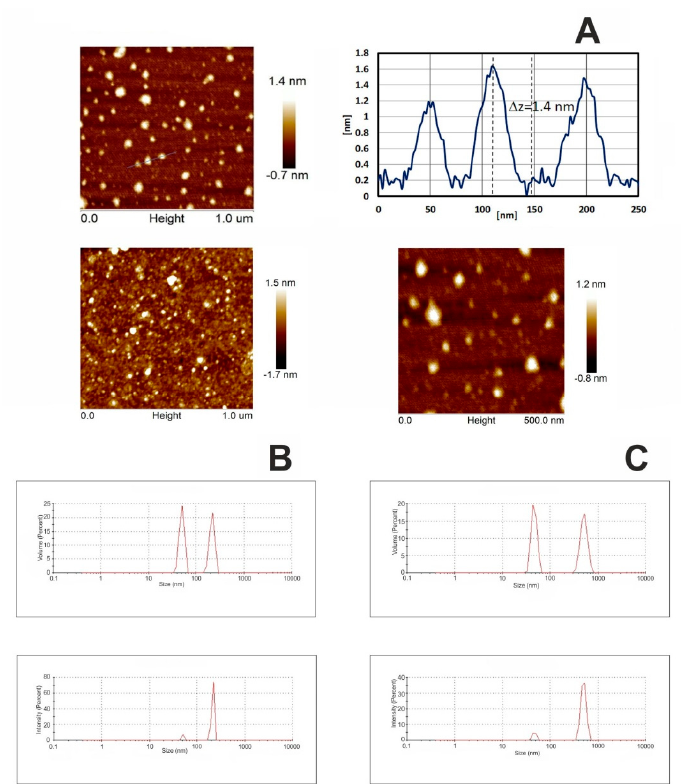
Figure 2. Atomic force microscopy (AFM) topography and surface profile of fullerenol. C 60 (OH) 36 was dissolved in water and precipitated on mica substrate ( A ). Dynamic light scattering (DLS) size distribution of the C 60 (OH) 36 in water ( B ) and in 0.02 M phosphate buffer pH 7.4 ( C ), showing the intensity and volume distributions of fullerenol-water and fullerenol-PBS preparations. Intensity-weighted average values were used to determine the hydrodynamic size, while volume distribution data was used to determine relative amounts of nanoparticles (NPs). Graphs in Figure 2B,C were produced by the Zetasizer Nano-ZS software.